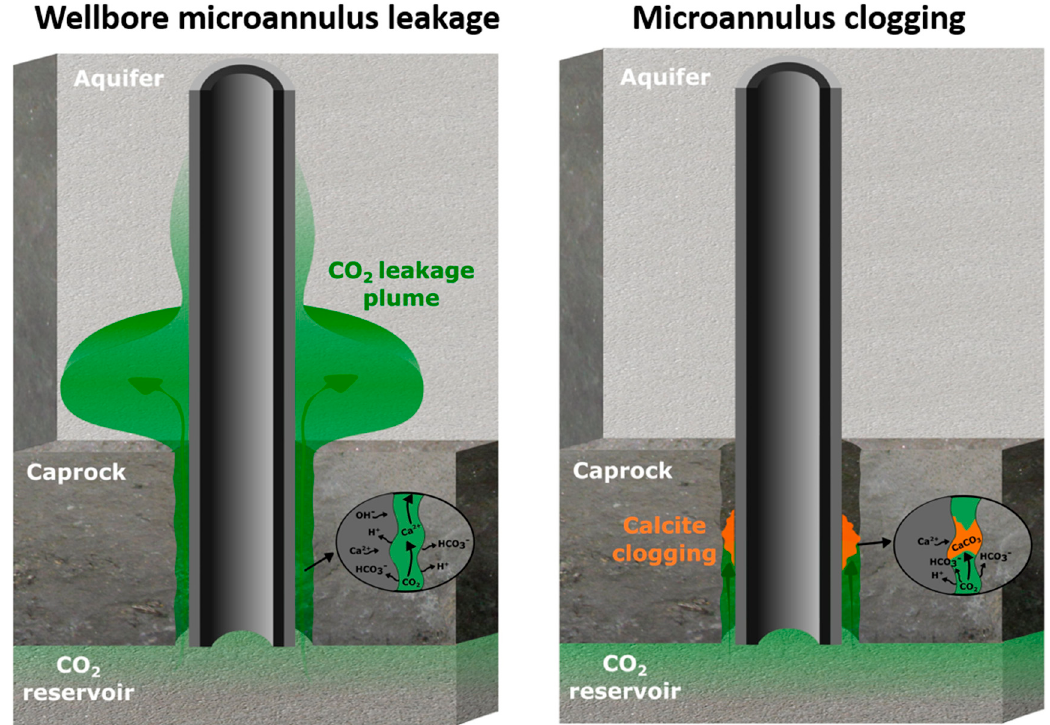
Figure 9. Graphical representation of the CO 2 leakage and CO 2 -reactive remediation.